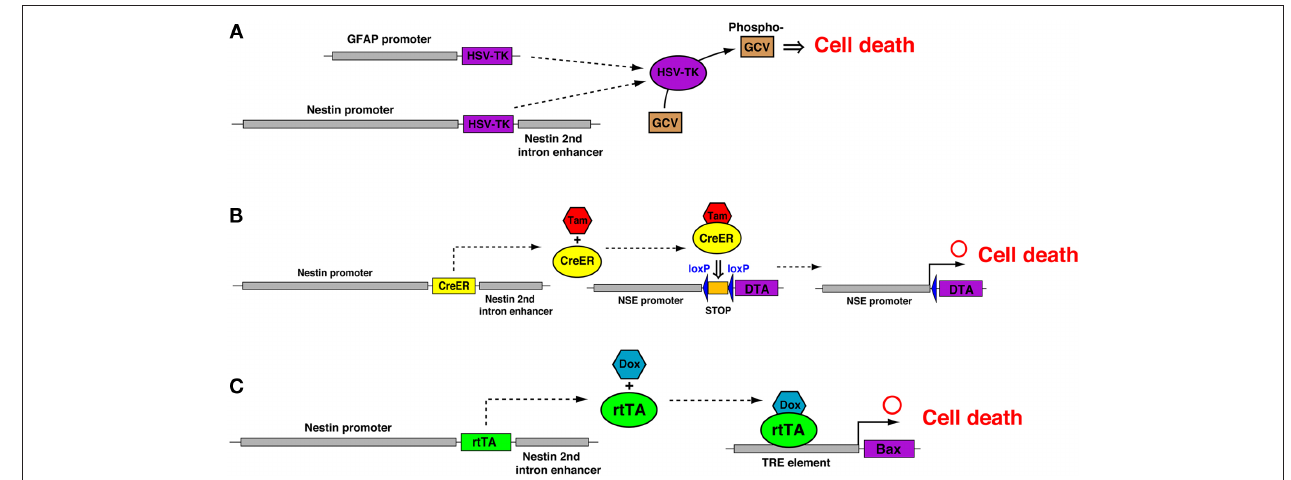
fragment A (DTA) is engineered into the locus of the neuron-specific enolase (NSE) gene. Activated CreER leads to the recombination of loxP sites and removal of the STOP cassette upstream of the DTA gene, thus allowing the expression of DTA from the NSE promoter. (C) In the Nestin-rtTA/TRE-Bax mice, doxycycline (Dox) activates the rtTA protein, which binds to seven TetO sequences (TRE) to drive the expression of the pro-apoptotic protein Bax, which activates the apoptosis pathway in